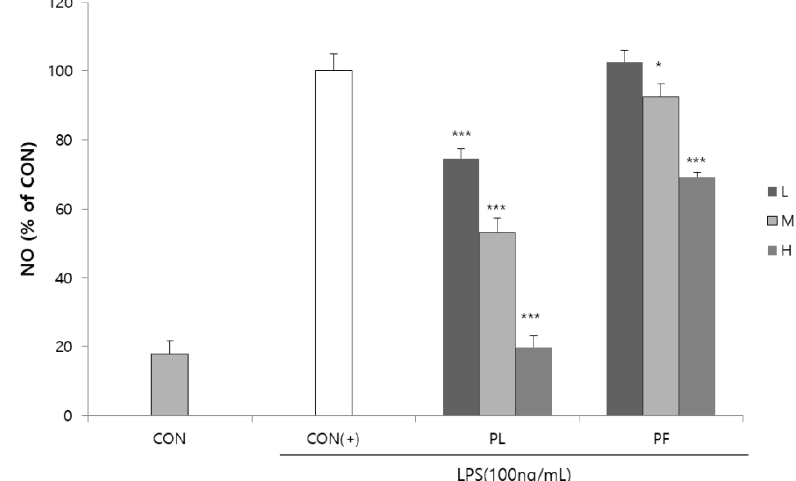
Figure 1. Inhibition of nitric oxide (NO) production by the extracts of pepper leaves (PL) and pepper fruits (PF) in lipopolysaccharide (LPS)-stimulated RAW 264.7 cells. RAW 264.7 cells were treated with 100 (L), 200 (M), and 500 (H) µg/mL PL and PF extracts in the presence of 100 ng/mL LPS for 18 h. Statistical significance is based on the difference compared with CON(+) (* p < 0.05, ** p < 0.01, *** p < 0.001).